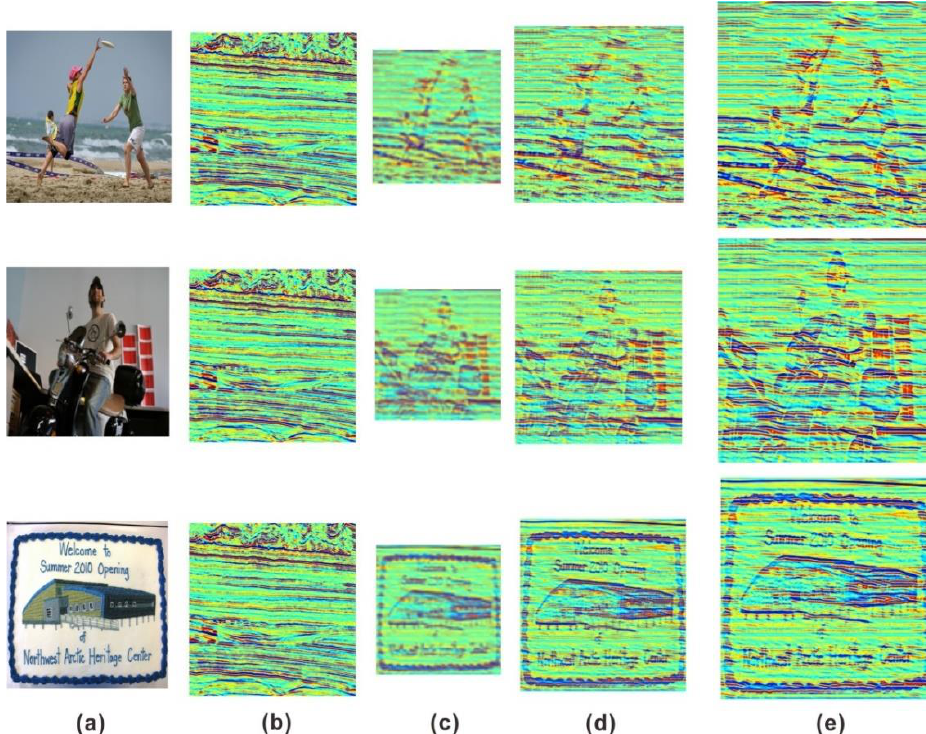
Figure 11. Experimental results. All the content and style images were observed by our network training. ( a ) Content. ( b ) Style. ( c ) Drafting network training results. ( d ) First training results of revision network: content weight = 2.0 and style weight = 1.0. ( e ) Second training results of revision